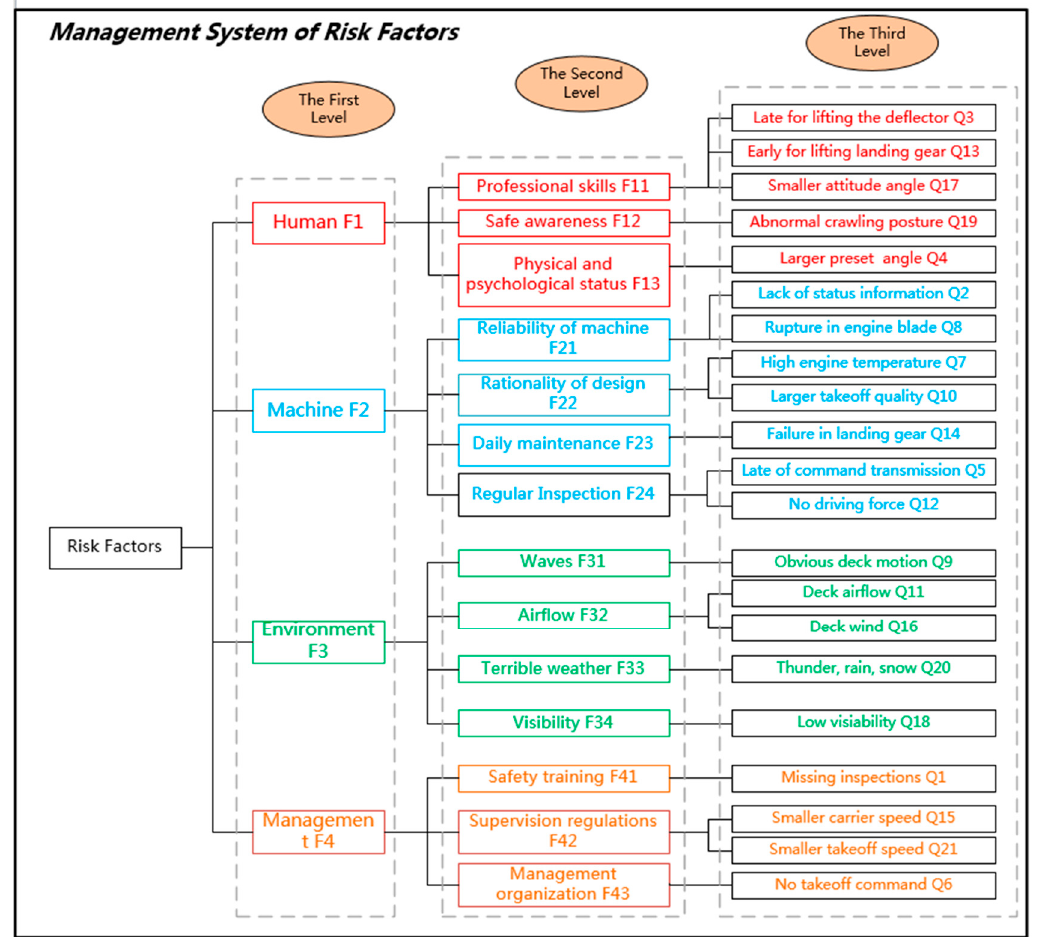
Figure 4. The classification of risk factors.